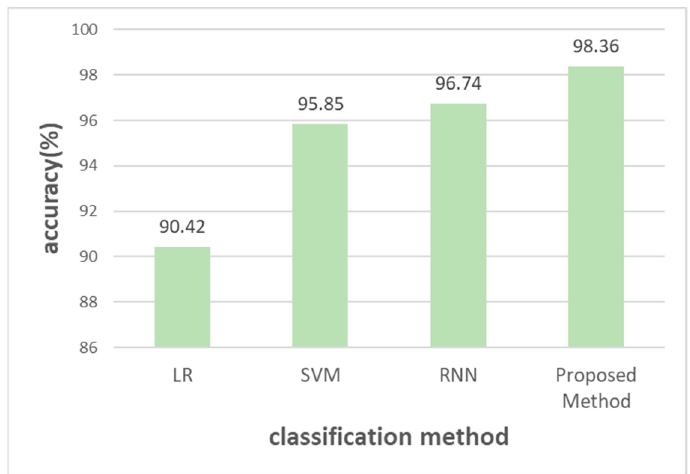
Figure 12. The performance of all methods.